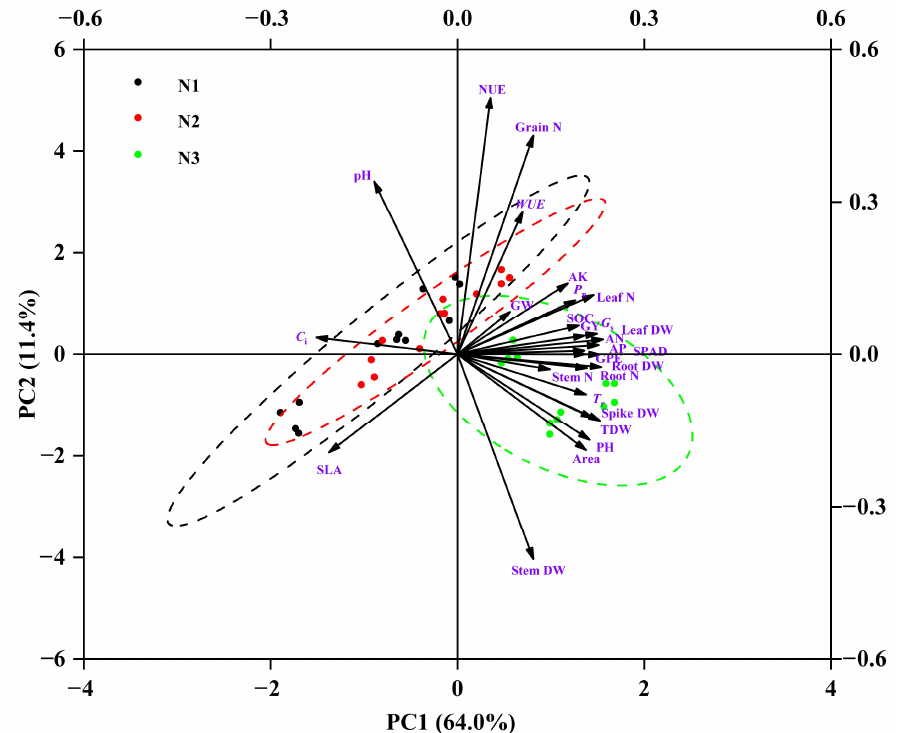
Figure 6. Biplot of first (PC1) and second (PC2) principal components of 36 evaluated traits with different nitrogen fertilizer treatments. AK—available potassium content, AP—available phosphorus content, Area—leaf area, C i —intercellular CO 2 concentration, GE—grains per ear, G s —stomatal conductance, Grain N—nitrogen content in maize grain, GW—100-grain weight, GY—grain yield, Leaf DW—dry weight of maize leaf, Leaf N—nitrogen content in maize leaf, MN—mineral nitrogen content, NUE—nitrogen utilization efficiency, P n —net photosynthetic rate, pH—soil pH,